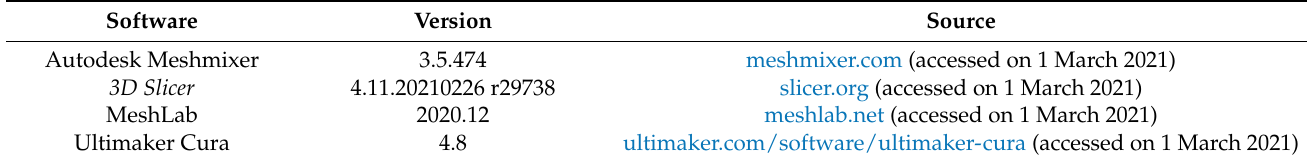
Table 1. The list of used software.